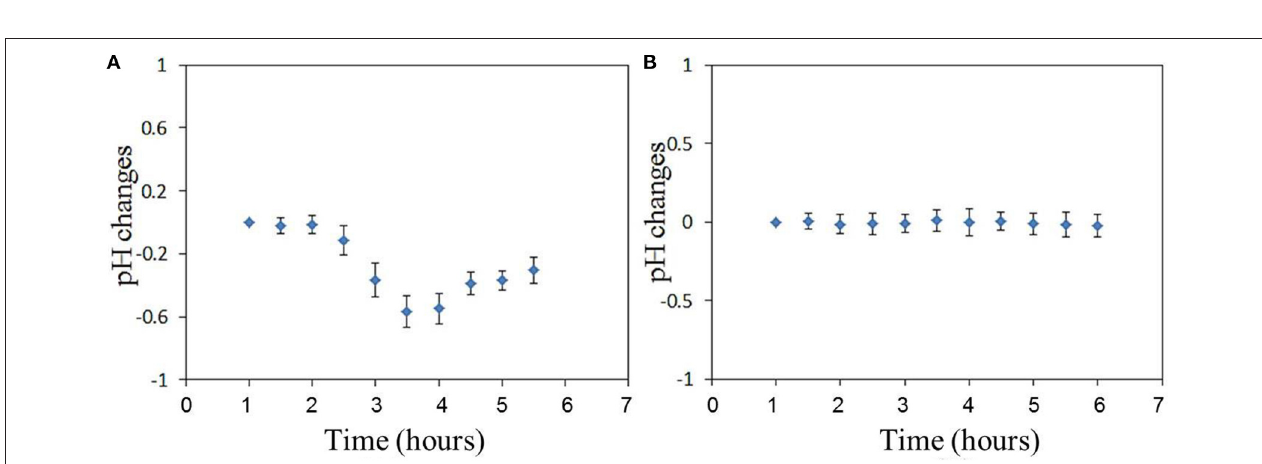
FIGURE 5 | The average pH e changes of (A) virus-bound cells and (B) virus–unbound cells ( n = 8).